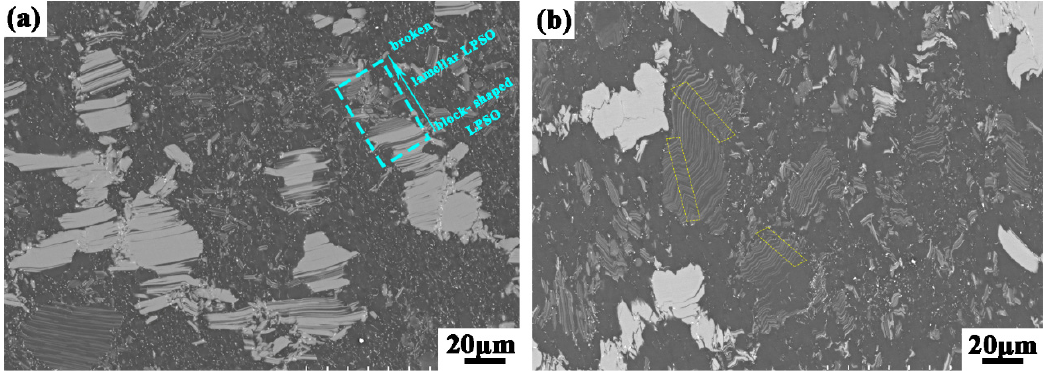
Figure 11. SEM maps of deformed samples at temperatures 653 K: ( a ) strain rate 0.001 s − 1 ; ( b ) strain rate 0.5 s − 1 (yellow square frame showed kinking, blue square frame showed the evolution of LPSO).